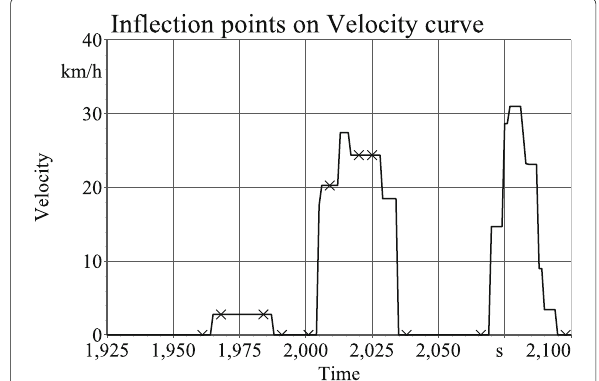
Fig. 3 Identifying Manoeuvres. Inflection points (denoted by ‘X’) on Velocity curve differentiate different